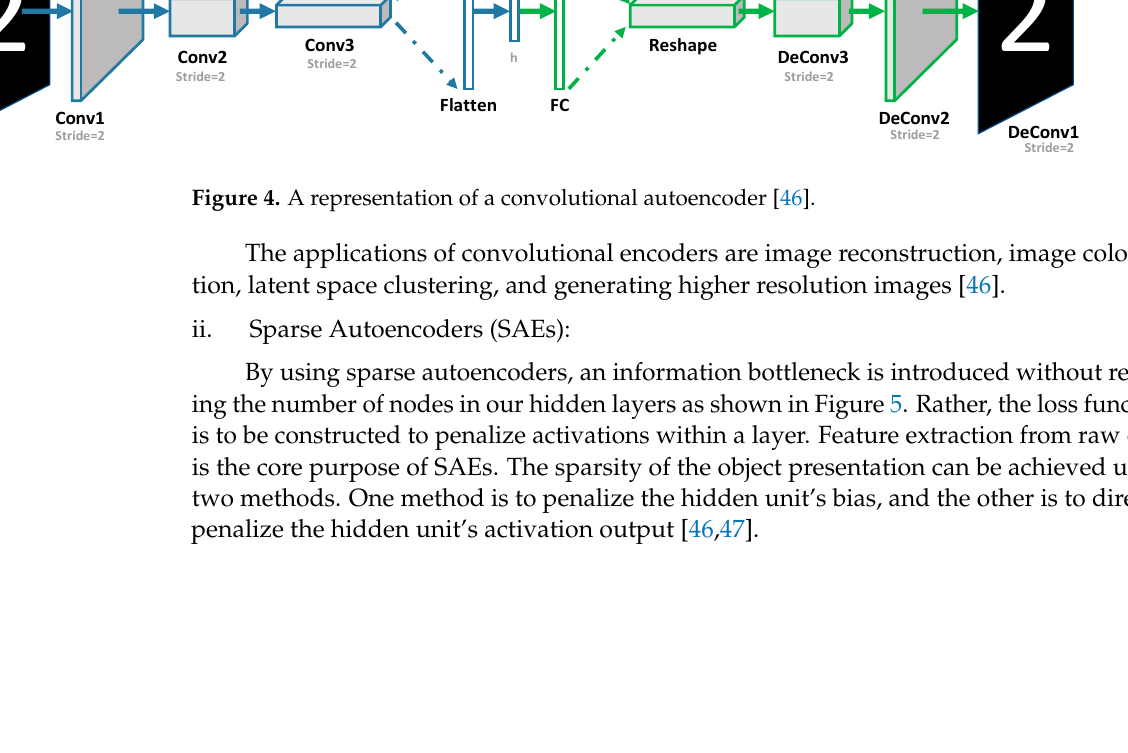
Figure 5. A representation of a sparse autoencoder [46].